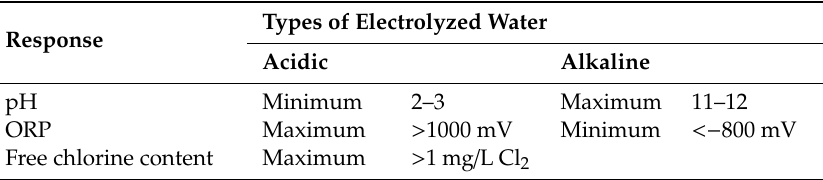
Table 2. Electrolyzed water (EW) desired target